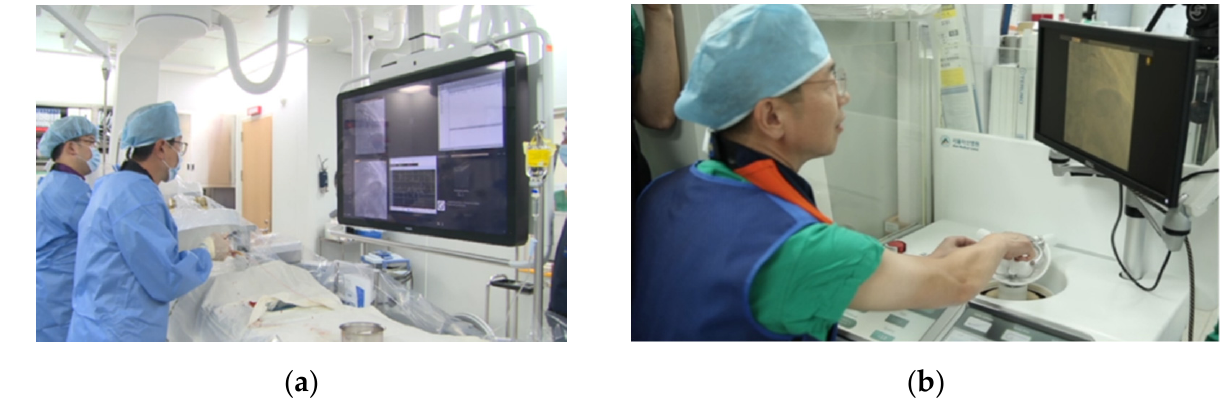
Figure 17. Setup of the clinical trial. ( a ) The slave robot and the patients in the operation room are shown. ( b ) The physician is located in the corner of the angiography room with the master console, behind a radiation-shielded glass wall.